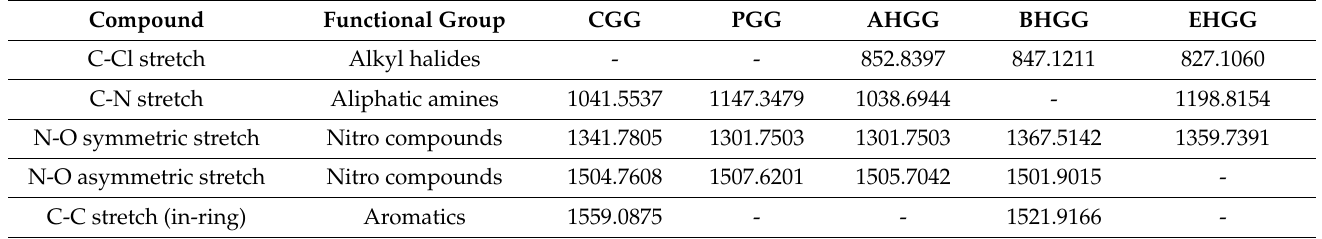
Figure 2. Spectral data of guar gum obtained by X-ray Diffraction (XRD): ( a ) crude guar gum (CGG); ( b ) purified guar gum (PGG); ( c ) acid hydrolyzed guar gum (AHGG); ( d ) basic hydrolyzed guar gum (BHGG); ( e ) enzymatic hydrolyzed guar gum (EHGG). Table 2. Functional groups evaluation of various guar gums at specific wavenumbers (cm − 1 ) in the infrared spectral